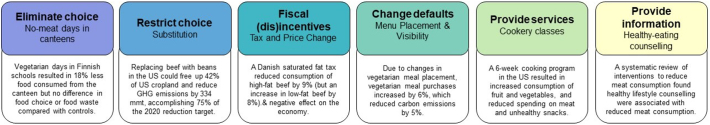
Examples of different intervention types to reduce meat overconsumption; darker colours represent potentially more effective but less feasible and socially acceptable options (based on data from Lombardini and Lankoski, 2013 (eliminate choice); Harwatt et al., 2017 (restrict choice); Bødker et al., 2015 (fiscal disincentives); Hansen et al., 2019 (change defaults); Flynn et al., 2013 (provide services); Diepeveen et al., 2013 (provide information)).